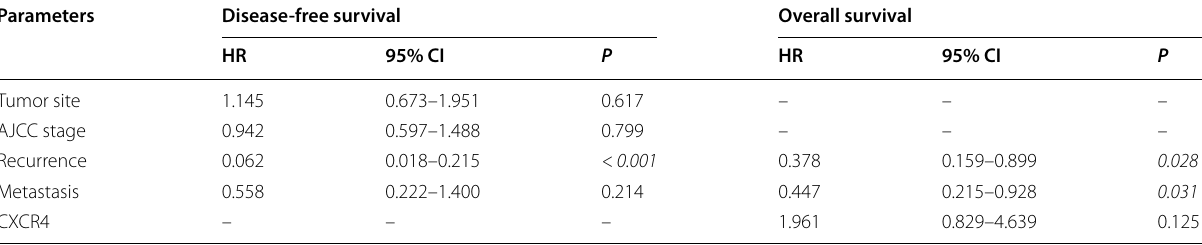
Table 3 Multivariate analysis of the prognostic values of clinicopathologic characteristics and protein expression in spo- radic MPNST